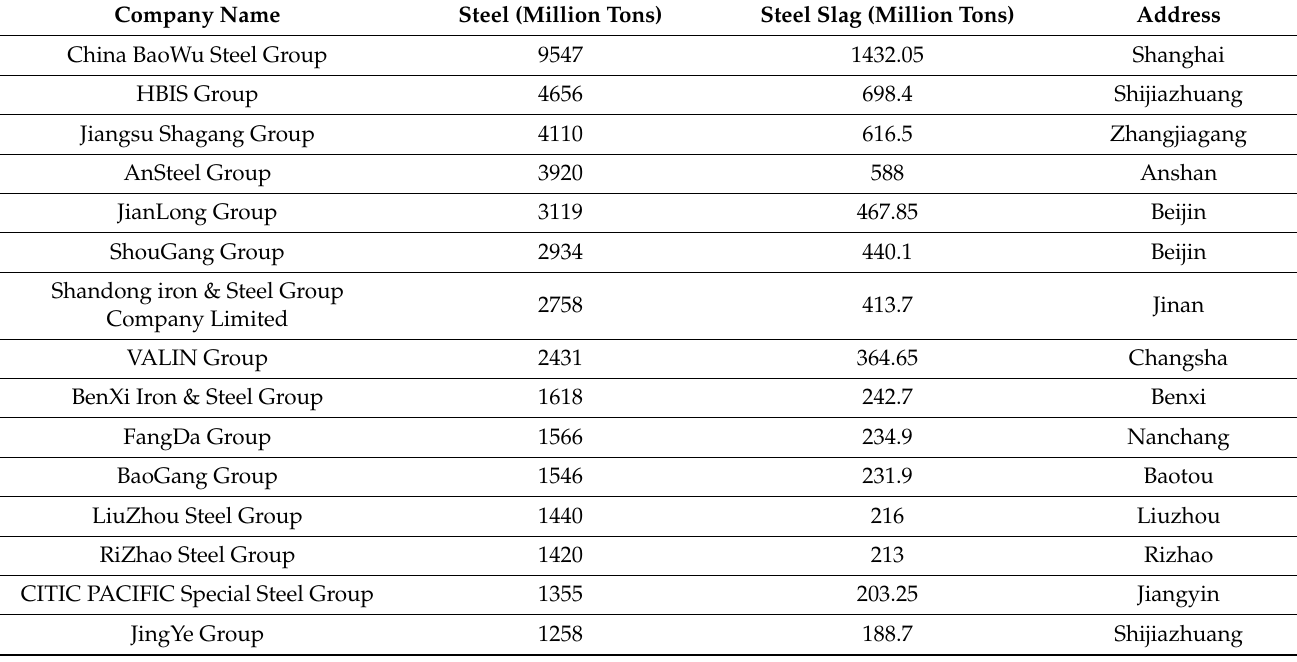
Table 1. Crude steel output and slag forecast of some Chinese iron and steel enterprises in